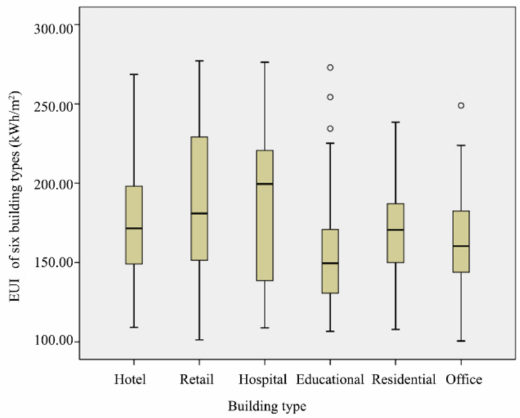
Figure 3. Box plot of heating EUI of di ff erent building